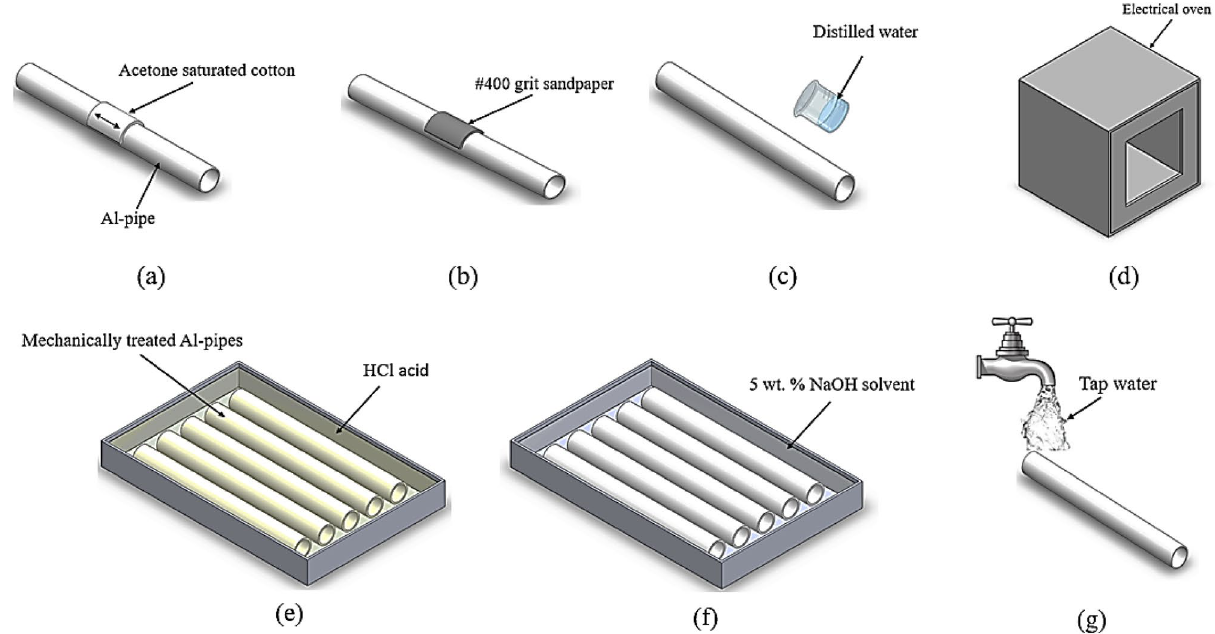
Figure 1. Surface treatment of